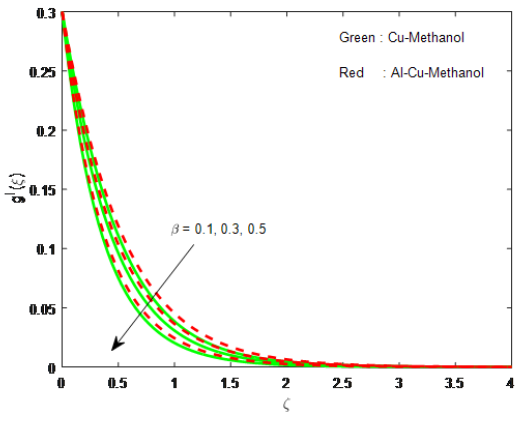
with increase in β . The profiles of θ ( ξ ) for disparate val- ues of Ek are plotted in Fig. 5. As fluid stores heat energy from frictional heat caused by Ek , we watch an inflation in fluid temperature for rising values of Ek . A keen obser- vation of Fig. 5 enables us to state that initially there is no difference between the profiles of Cu-methanol and Al-Cu- methanol but temperature curves of Al-Cu nanofluid beats that of other as ζ → ∞. Fig. 6 elucidates the variation in θ ( ξ ) with H 1.2 and 2.5. As we already mentioned H H 1 , H 2 > 0. We know that positive values of H 1 , H 2 gives rise to heat in the flow. Ergo, we notice a development in temperature distribution. Fig. 7 is the graphical represen-